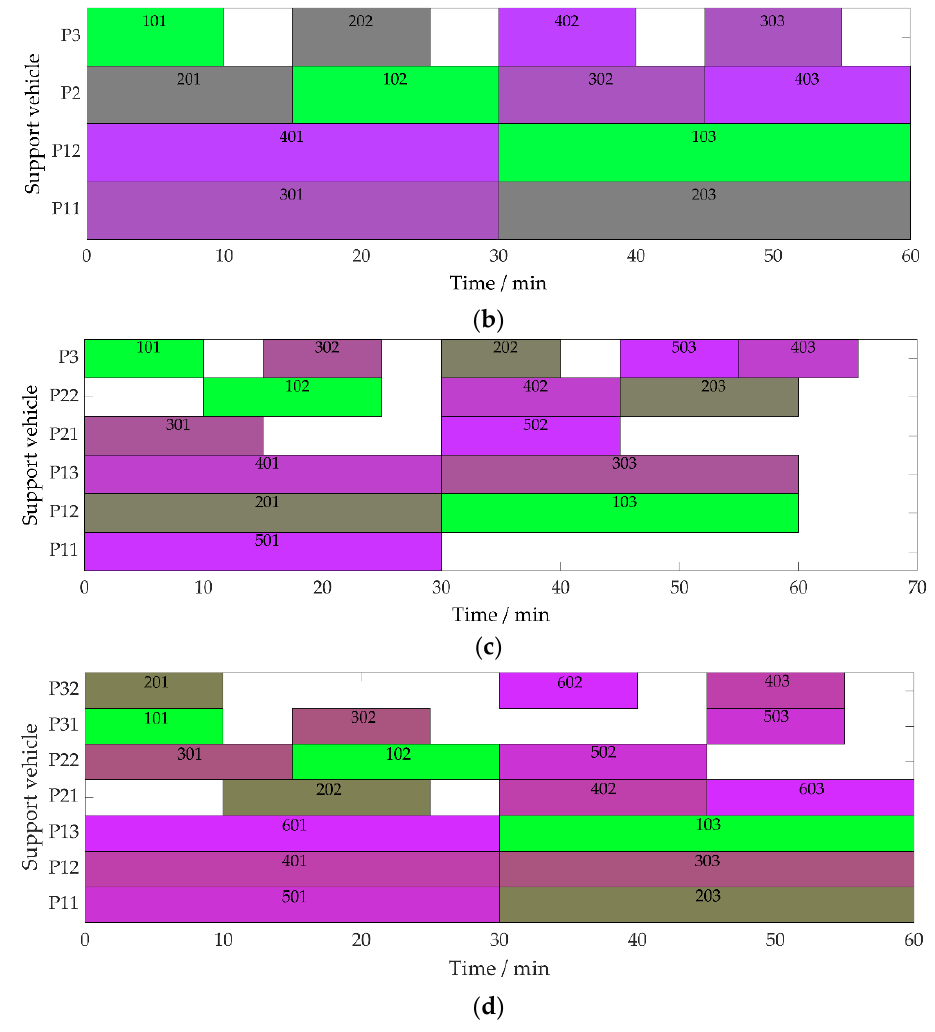
Figure 11. Change of population fitness value. ( a ) 3 aircraft, ( b ) 4 aircraft, ( c ) 5 aircraft, ( d ) 6 aircraft. Table 8. Support vehicles utilization and completion time of three operations.